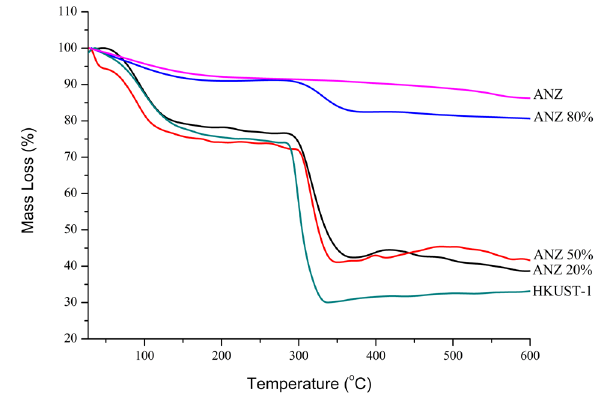
Figure 5 : Thermograms of HKUST-1, ANZ, and the ANZ@HKUST-1 composites.